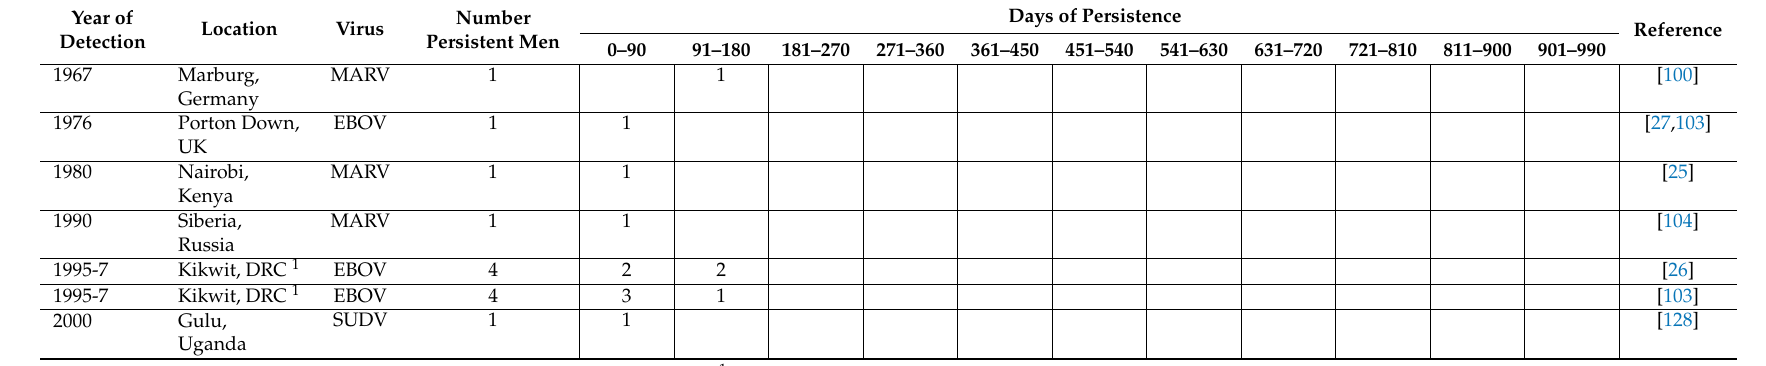
Table 1. Compilation of persistent filovirus infections in male survivors: 1967–2000.